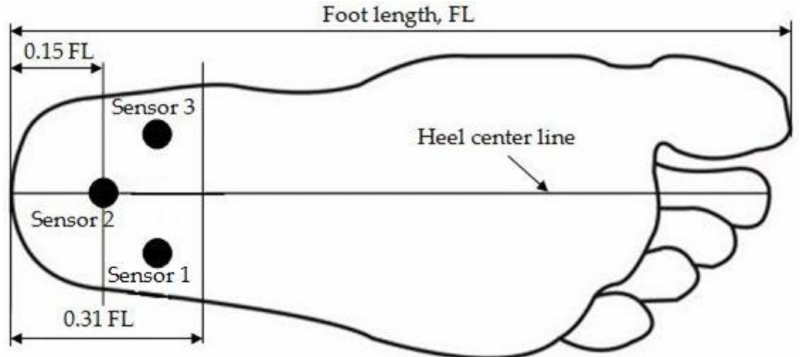
Figure 4. Illustration of the Force Sensing Resistor (FSR) sensor